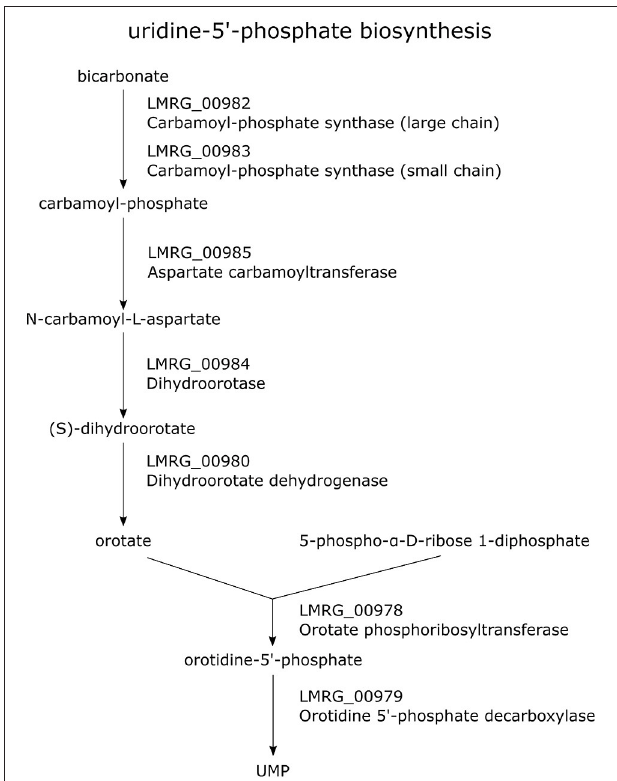
FIGURE 2 | Pathway of uridine-5 ′ -phosphate biosynthesis. Genes encoding the enzymes involved in this pathway are labeled in purple. All genes in the TU LMRG_00985-LMRG_00978 except LMRG_00981 are shown in this